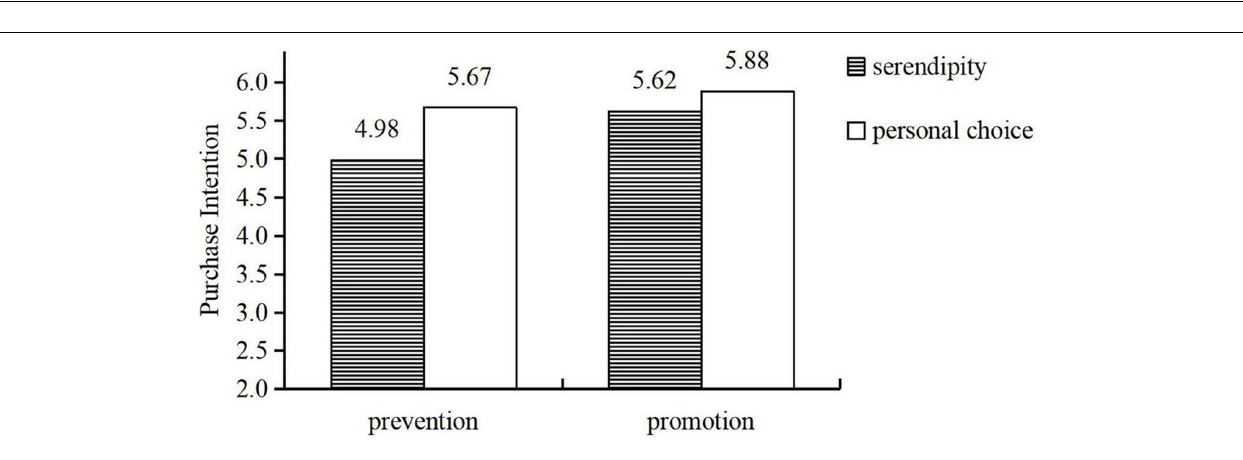
FIGURE 3 | The moderate effect of regulatory